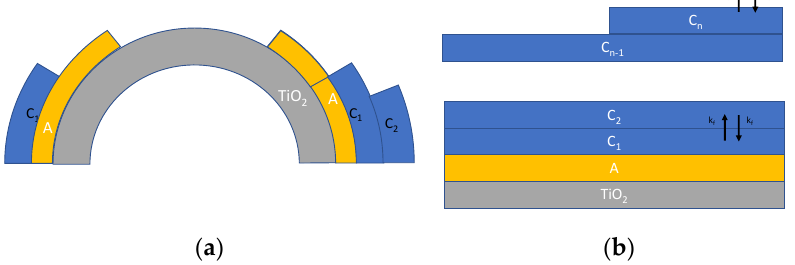
Figure 3. Schematic representation of multilayer adsorption of water on TiO 2 nanoparticles. ( a ) Multilayer adsorption taking into account the surface increase [19] and ( b ) multilayer adsorption route according to [19] described by Equation (6).